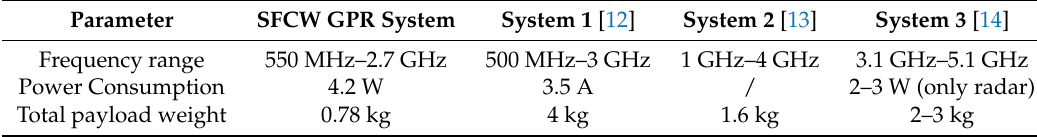
Table 2. Comparison of GPR system used for UAV